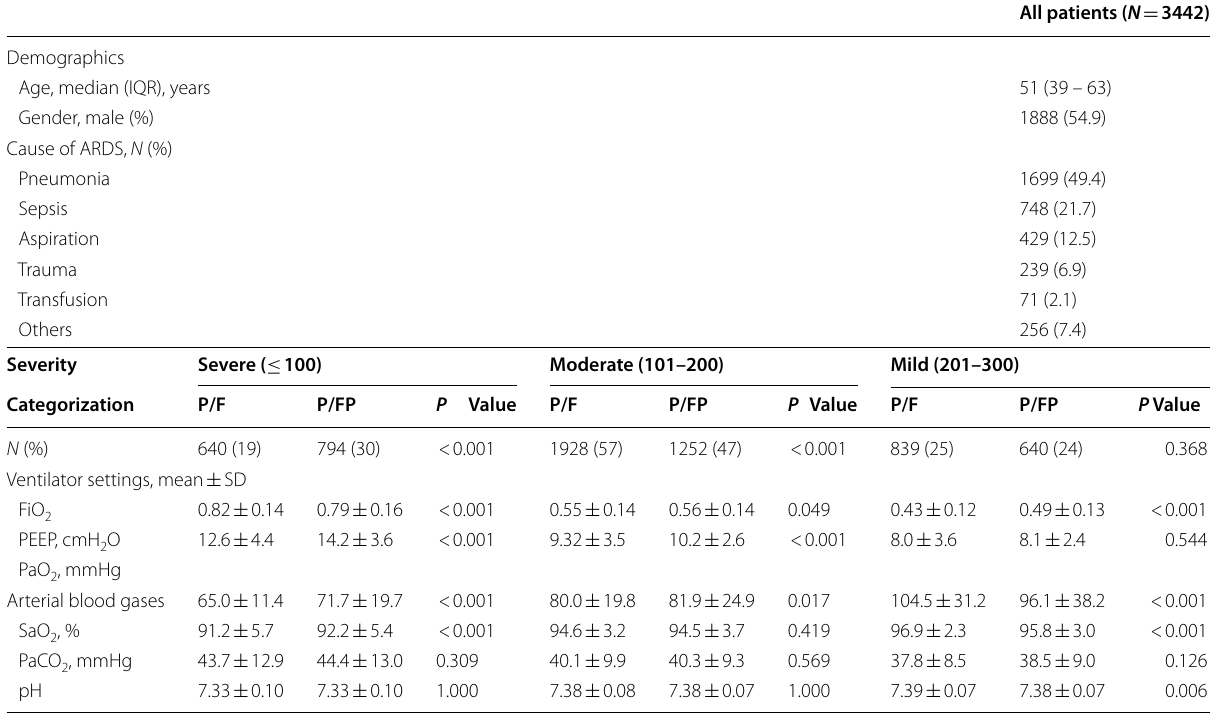
P values refer to comparisons between patients classified according to the P/F ratio versus patients classified according to the P/FP ratio in each severity category. Definition of abbreviations: ARDS acute respiratory distress syndrome, FiO 2 fraction of inspired oxygen, IQR interquartile range PaCO 2 partial pressure of